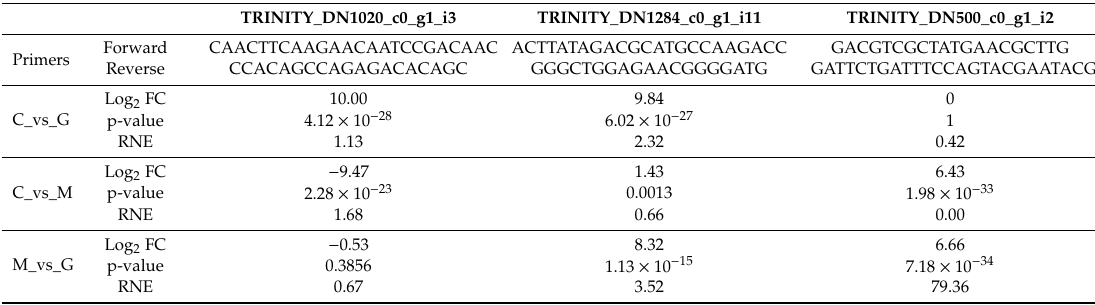
Table 4. qRT-PCR validation. Log 2 FC represents the log 2 values of the fold change of a transcript identified by the RNA-Seq while RNE represents the relative normalized expression of a transcript identified by